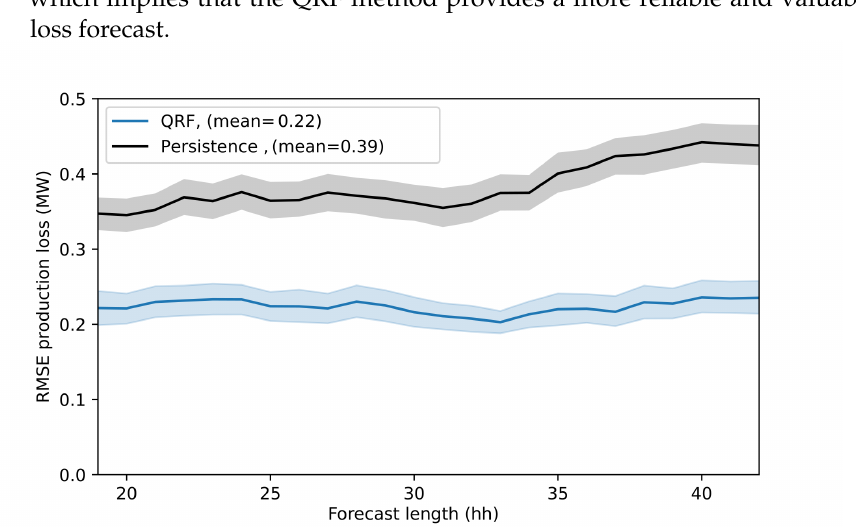
Figure 8. Persistence forecast RMSE vs QRF including station name option RMSE. The shading shows the 2.5–97.5 uncertainty range estimated with